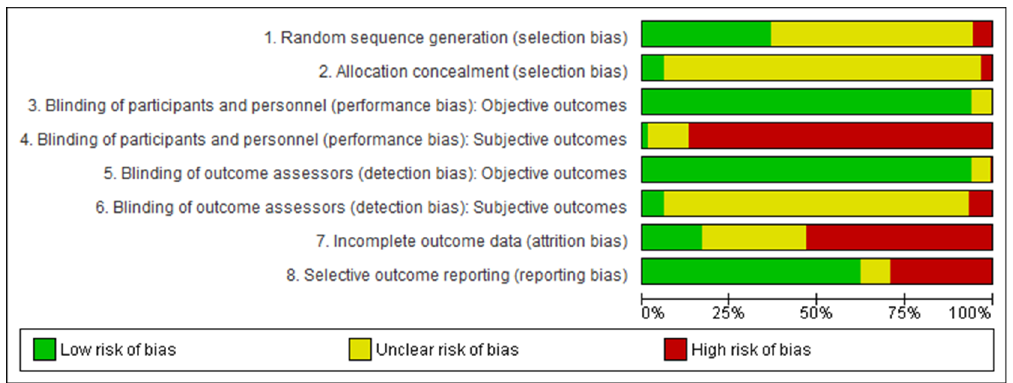
Figure 2. Risk of Bias Graph.